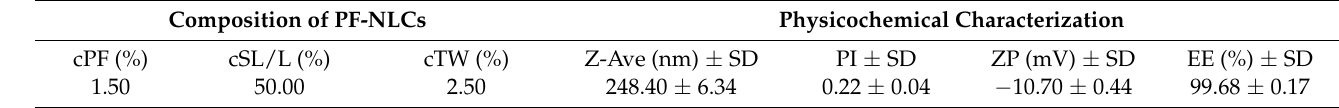
Table 1. Composition and physicochemical characterization of the selected nanostructured lipid carriers of Pranoprofen (PF-NLCs). The data were obtained from the mean of three experiments ( n = 3). Composition of PF-NLCs Physicochemical